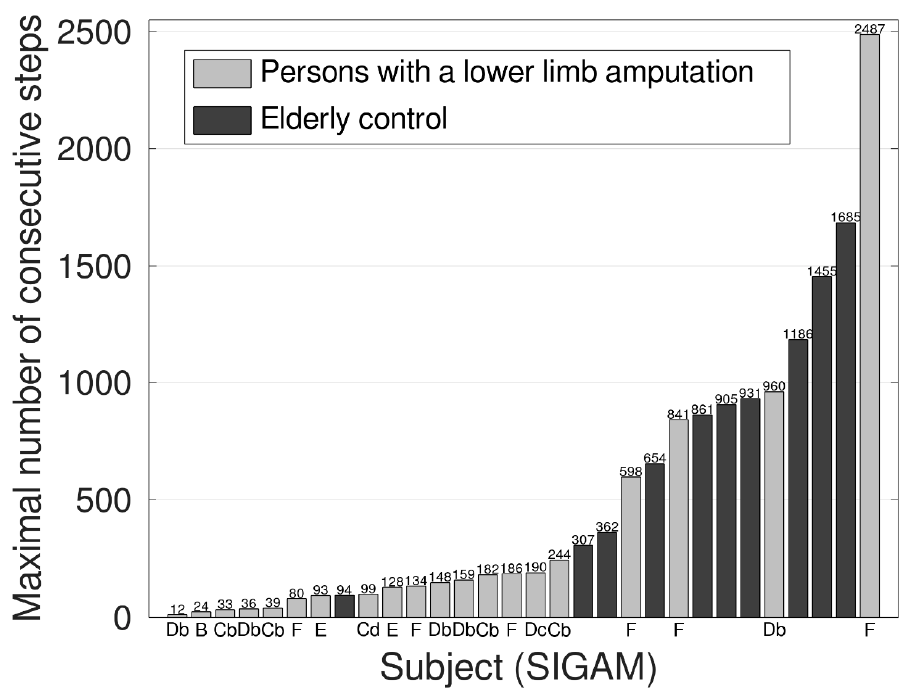
Figure 1. Maximal numbers of consecutive steps of each subject. The SIGAM mobility grade is given for every subject of the persons with a lower limb amputation. B = Therapeutic use only for transfers, C = Walks on level ground less than or equal to 50 m with (Cb) / without aids (Cd), D = Walks outdoor on level ground only, in good weather, more than 50 m with 2 crutches / sticks (Db) or 1 crutch / stick (Dc), and E = Walks more than 50 m, no aids, except in adverse terrain or weather, F = normal or near normal gait.